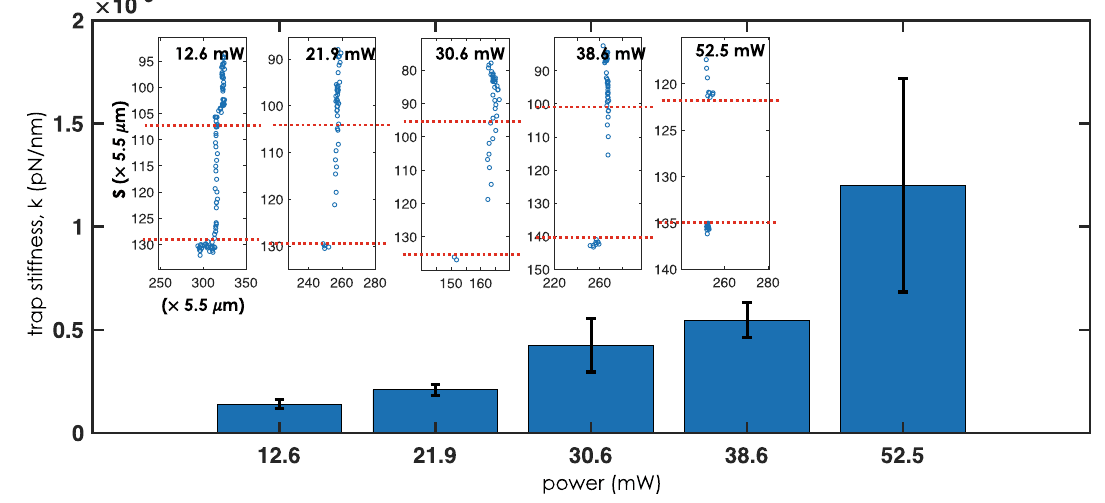
Figure 3. Trap stiffness k (pN/nm) of LOT at varying light intensity, 12.6–52.5 mW. The insets show the time taken by a single bead to reach the trap-center with increasing intensity, where the number of blue dots indicates the number of frames taken during the trapping process.